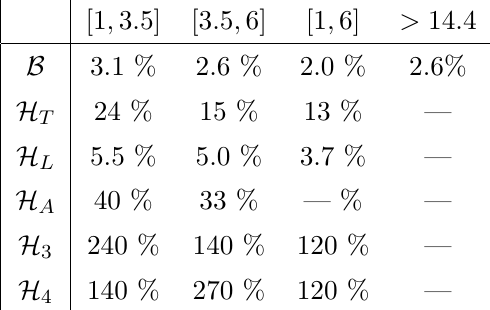
Table 4 . Projected statistical uncertainties that we expect at Belle II with 50 ab (cid:0) 1 of integrated luminosity. The (cid:12)rst row gives the considered q 2 bin in GeV 2 . The total projected error is obtained by adding a 5 : 8(3 : 9)% systematic uncertainty to all low- q 2 (high- q 2 )